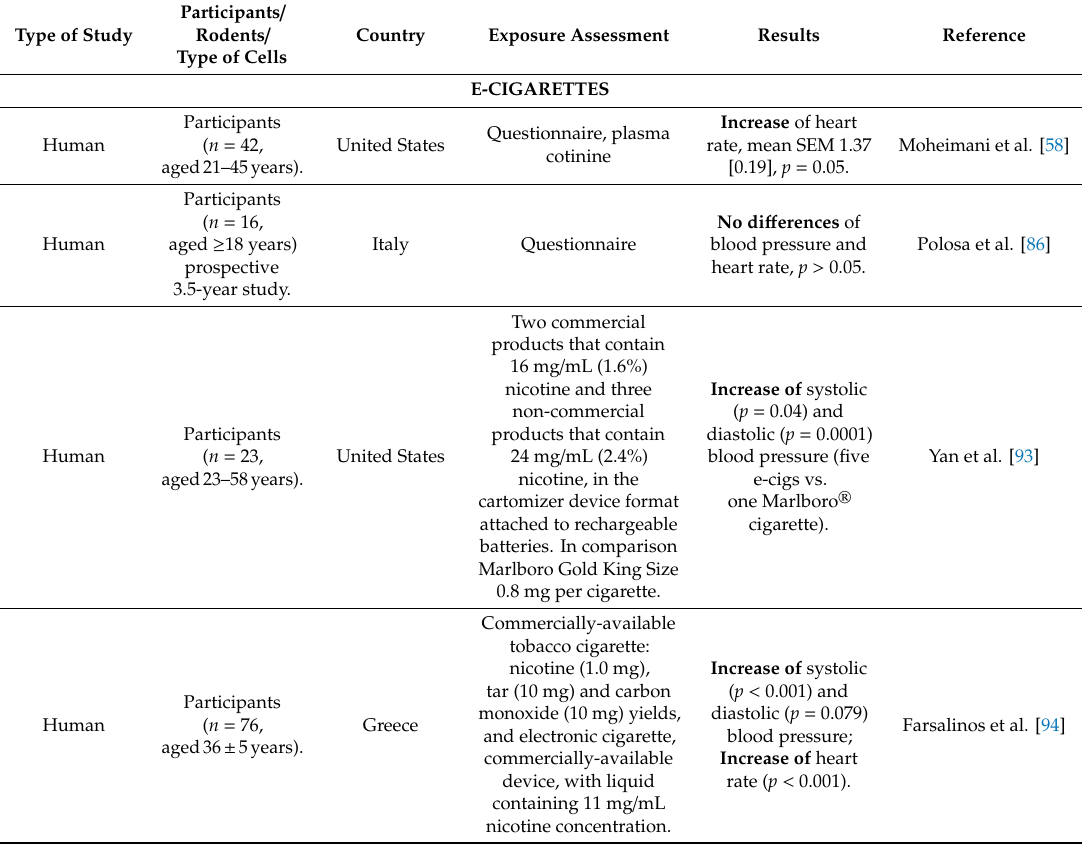
Table 6. The impact of electronic cigarettes use and tobacco smoke exposure on arterial